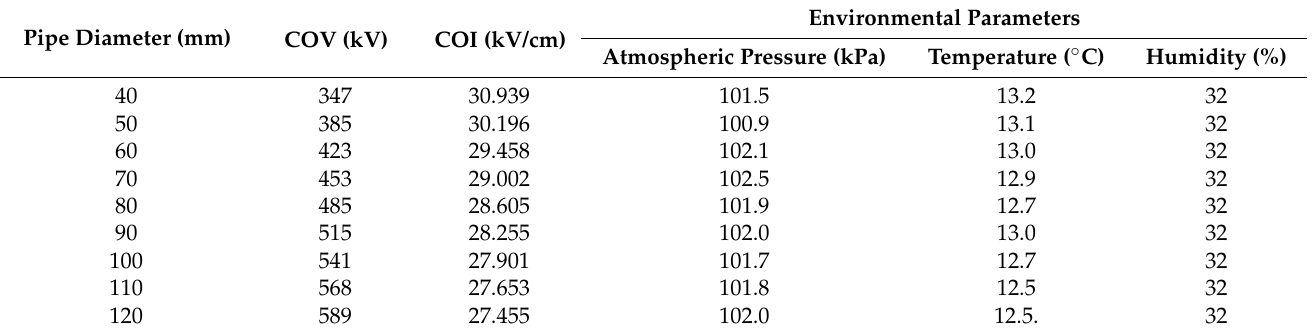
Figure 10. Calculation results of electric field distribution of the COI test model. Table 1. COI test results of circular grading rings with ring diameter of 800 mm and different pipe diameters.